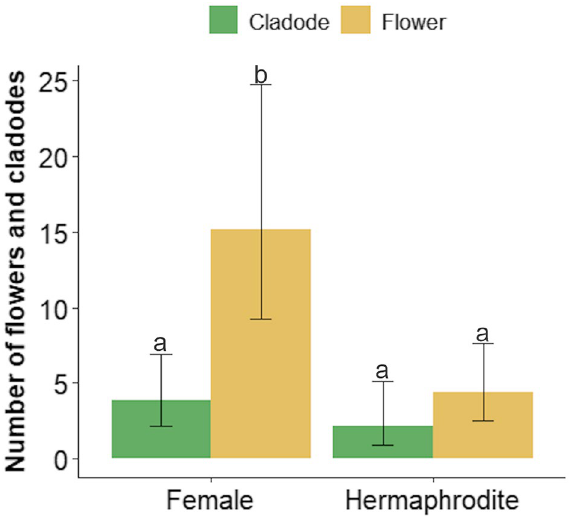
Figure 3. Comparison of the number of flower and cladode buds between sexual forms of Opuntia robusta in central Mexico. We fitted a generalized linear model with negative binomial error distribution. Different letters denote significant differences between the mean values at P ≤